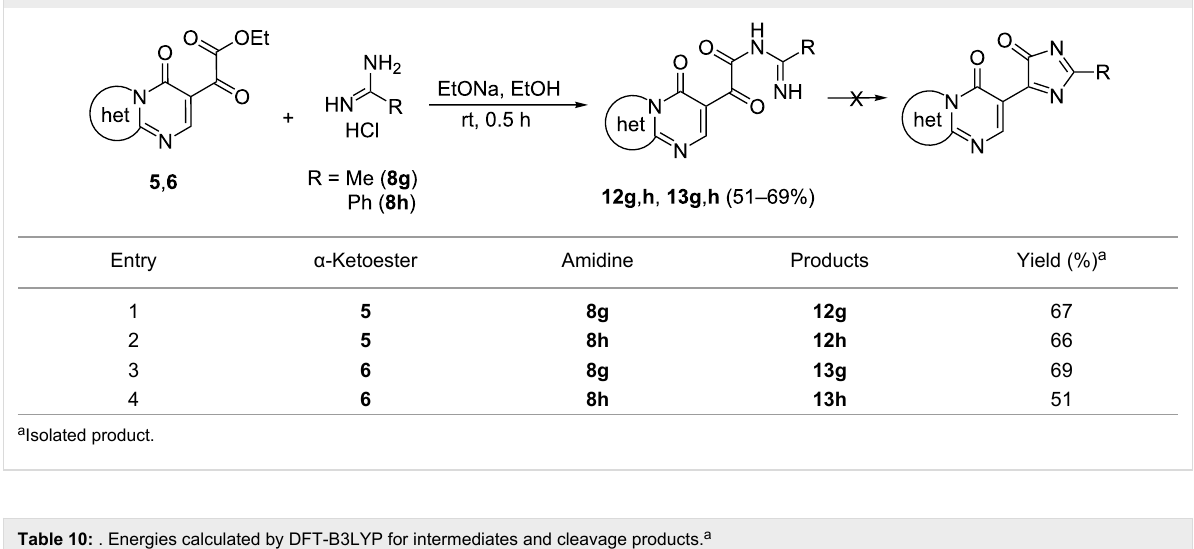
Table 10: . Energies calculated by DFT-B3LYP for intermediates and cleavage products.